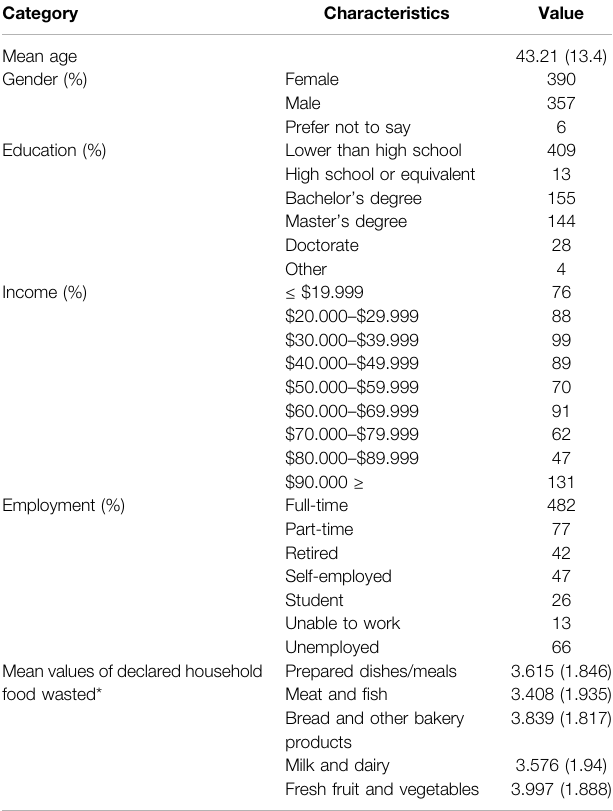
TABLE 2 | Description of the study group – n =